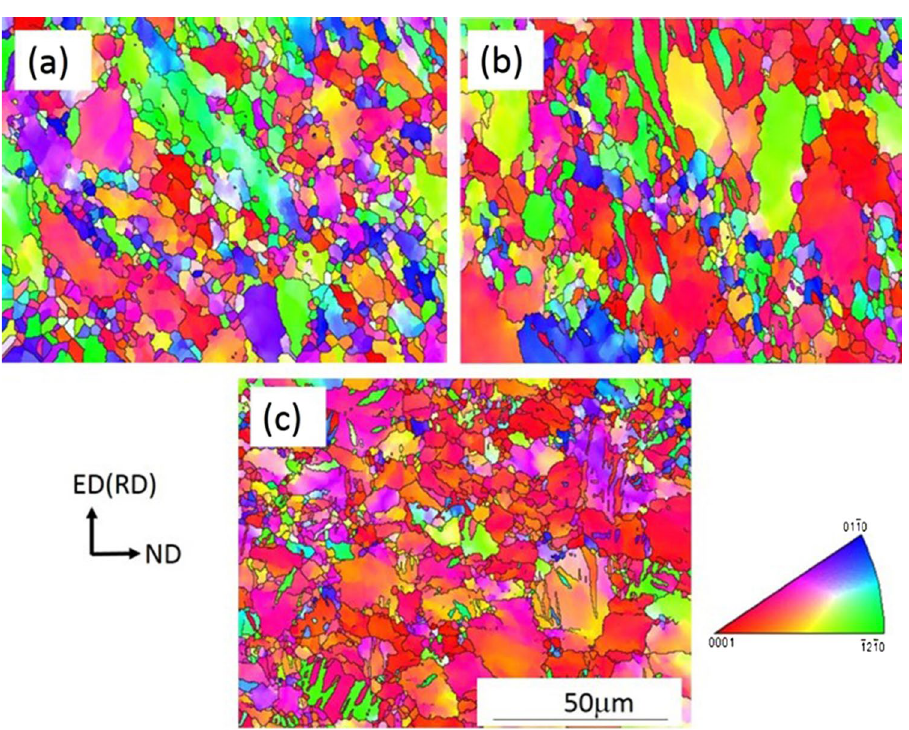
Figure 3. EBSD grain orientation diagram of Mg–2Y–0.6Nd–0.6Zr alloy in different states. ( a ) ECAP4passes, ( b ) ECAP4Passes + rolling, ( c ) ECAP4Passes + liquid